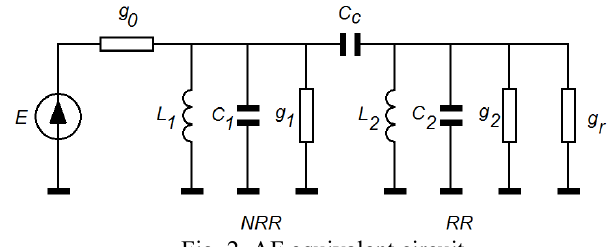
Fig. 2. AF equivalent